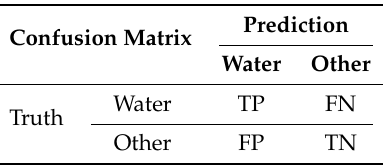
Table 3. Confusion